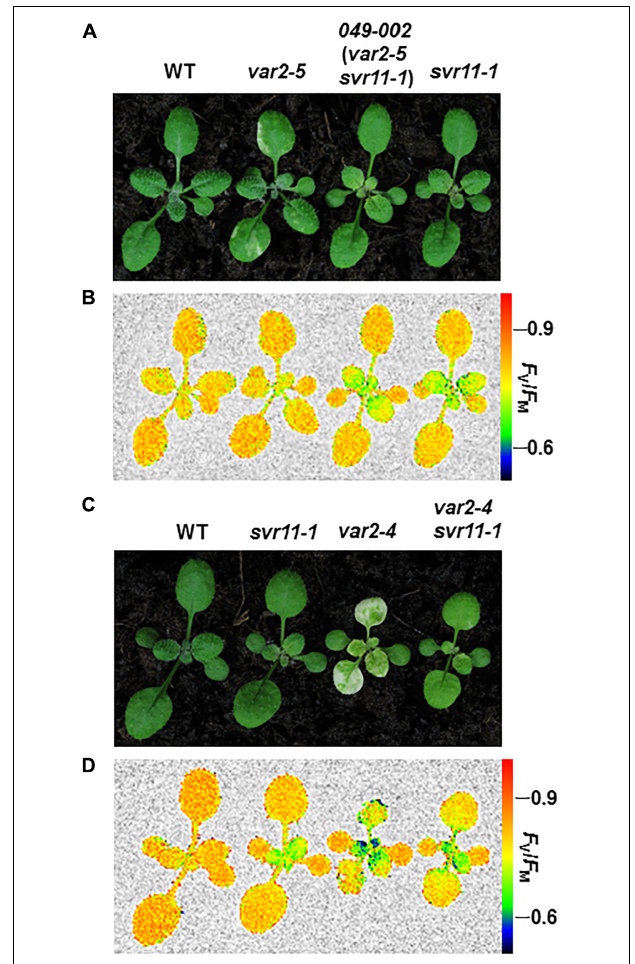
FIGURE 1 | Phenotypes of single and double suppressor mutants. (A) Representative 2-week-old seedlings of wild type (WT), var2-5 , double suppressor mutant 049-002 ( var2-5 svr11-1 ), and svr11-1 plants. (C) Representative 2-week-old seedlings of wild type (WT), svr11-1 , var2-4 , and the double mutant var2-4 svr11-1 . (B,D) Representative F V / F M measurement of the same group of plants used in (A,C) , respectively. The false color scale representing for the value of F V / F M is at the right of the figure. The measurement of F V / F M was repeated three times.